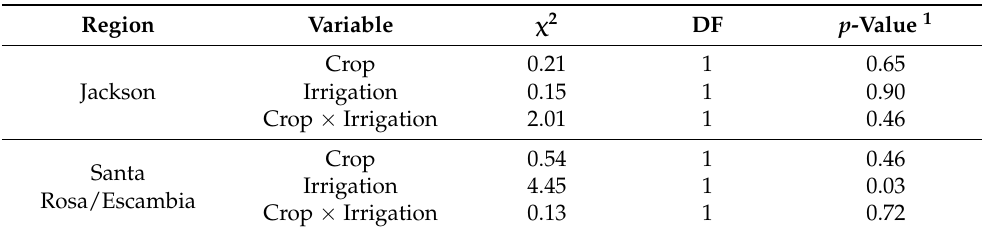
Table 1. Wald χ 2 type III analysis of variance for crop and irrigation system on the H. zea moth catch in Jackson and Santa Rosa/Escambia, Florida, from June 2017 to June 2019.